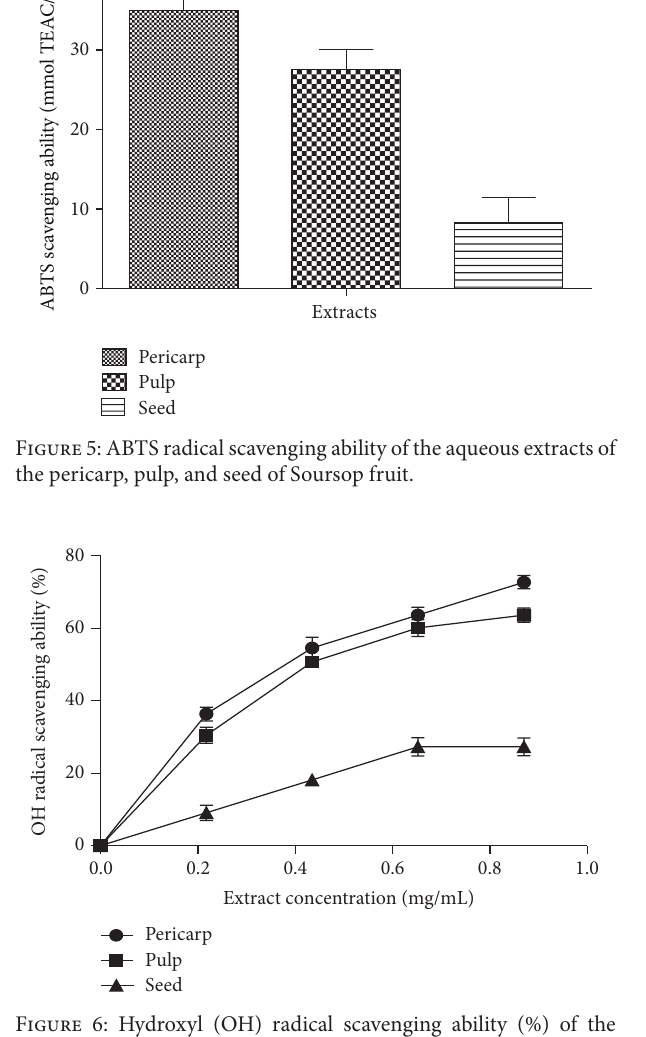
Table 2: Total phenol and flavonoid contents and ferric reducing antioxidant property (FRAP) of aqueous extracts of different parts of Soursop fruit (mg/100g).